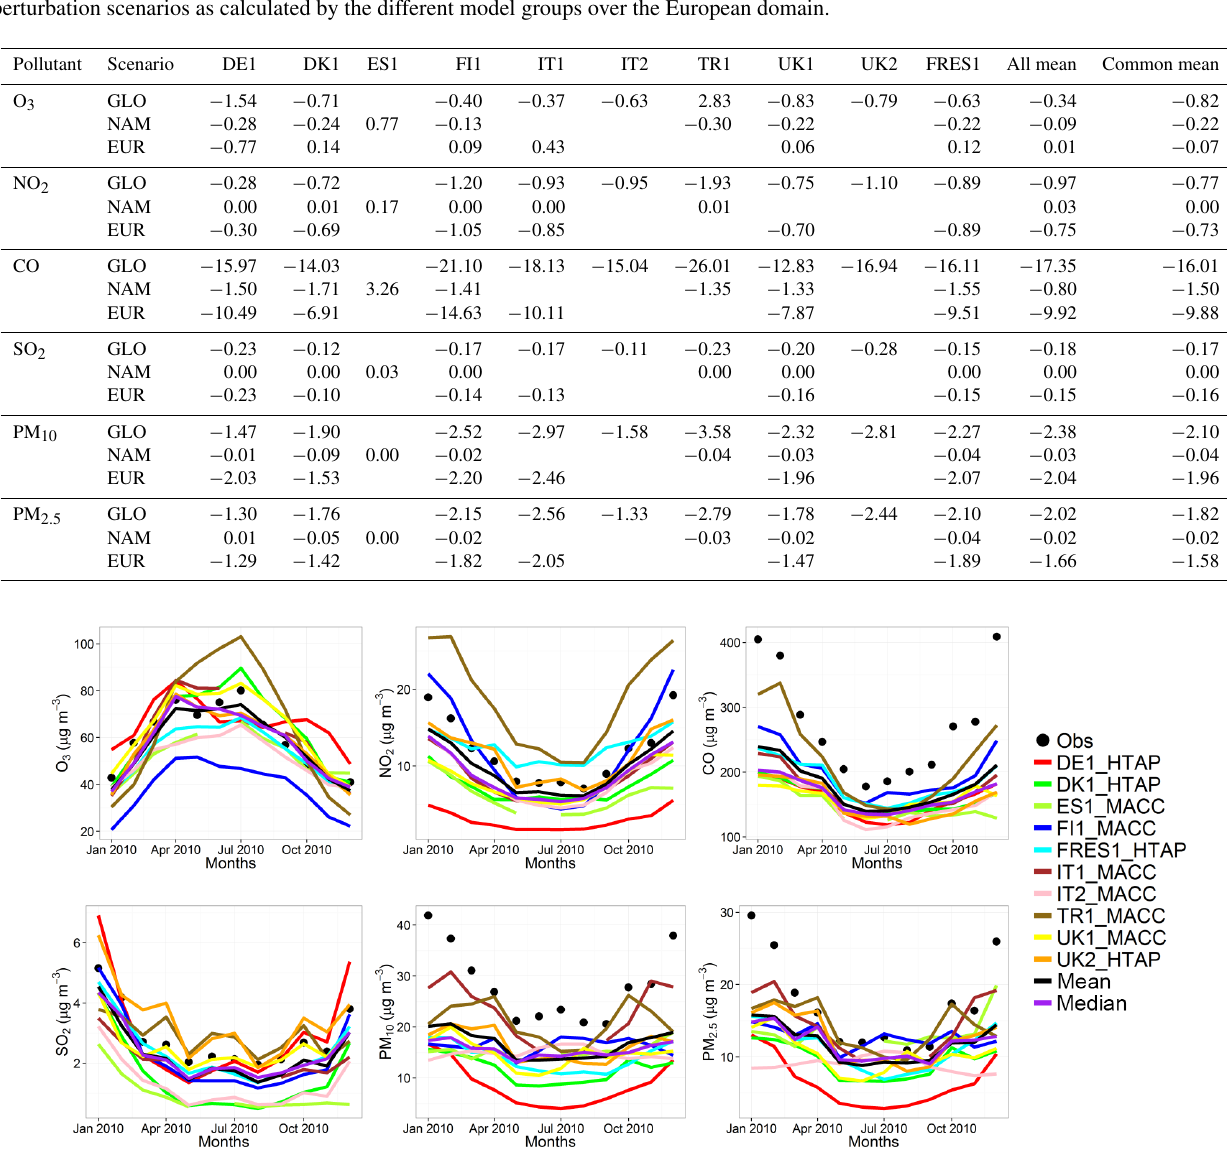
Figure 1. Observed and simulated monthly mean air pollutant levels, averaged over the monitoring stations over